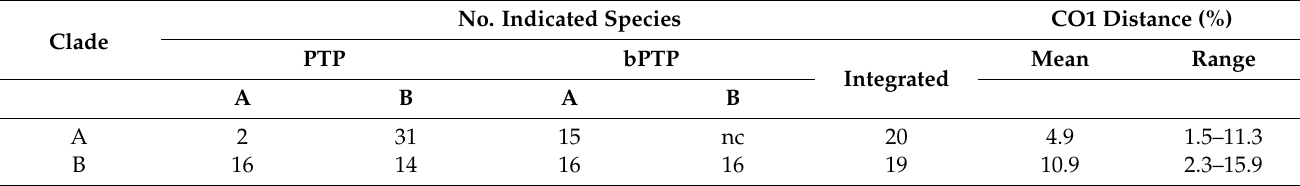
Table 1. Number of indicated species within each of the ten major clades (A–J; see Figure 3). Data are for PTP (maximum likelihood), bPTP (Bayesian inference), and integrated assessment (considering morphological, distributional and CO1 information). For PTP and bPTP analyses, data are provided for assessments of the full tree (A) and each clade individually (B). The totals include specimens outside the ten major clades. For the integrated assessment, the CO1 distances among species (calculated in MEGA) within each clade are